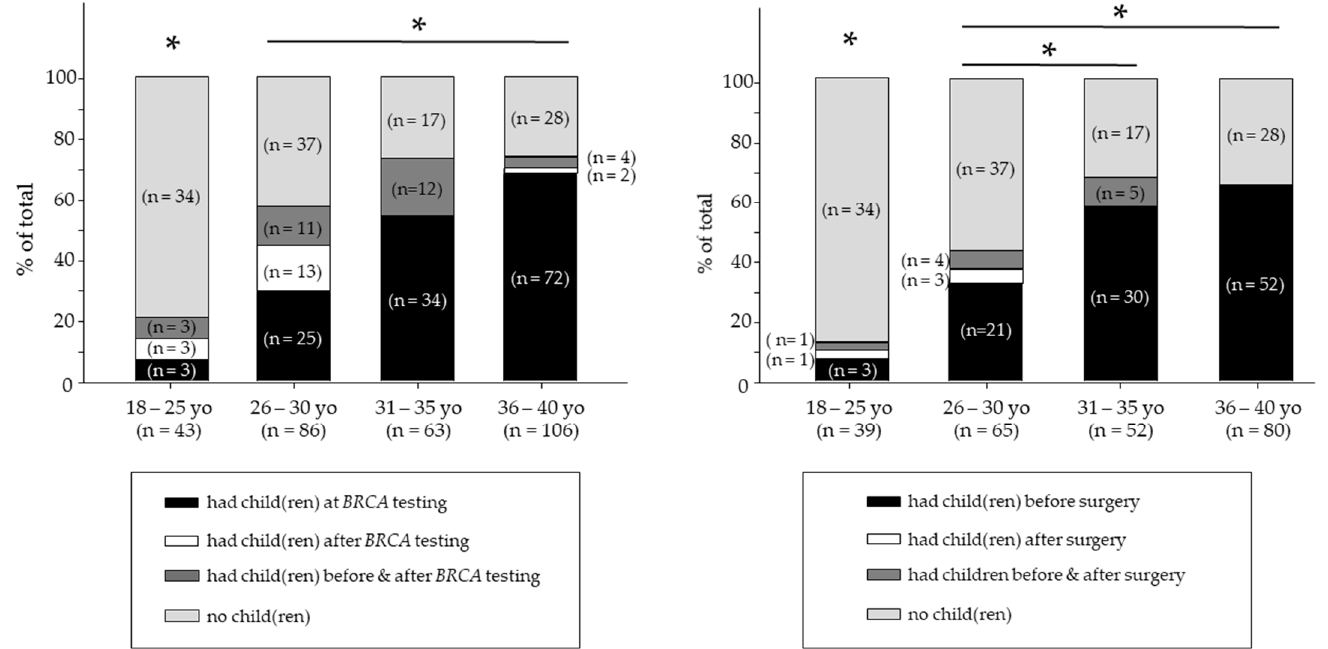
Figure 1. Childbearing status in BRCA + women at the time of testing (left panel, n = 298) and risk-reducing surgery (right panel, n = 236). The childbearing status among 18–25 year-old women differed significantly from other age groups. Bars depict comparisons, * denotes p < 0.001.